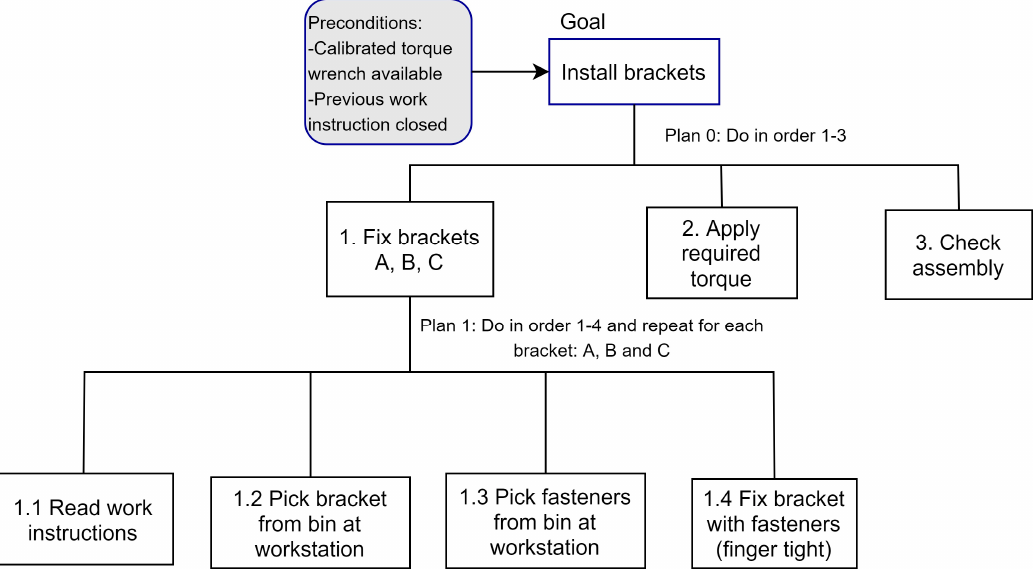
Figure 8. HTA diagram for the breakdown of the critical task No.1 (install brackets).